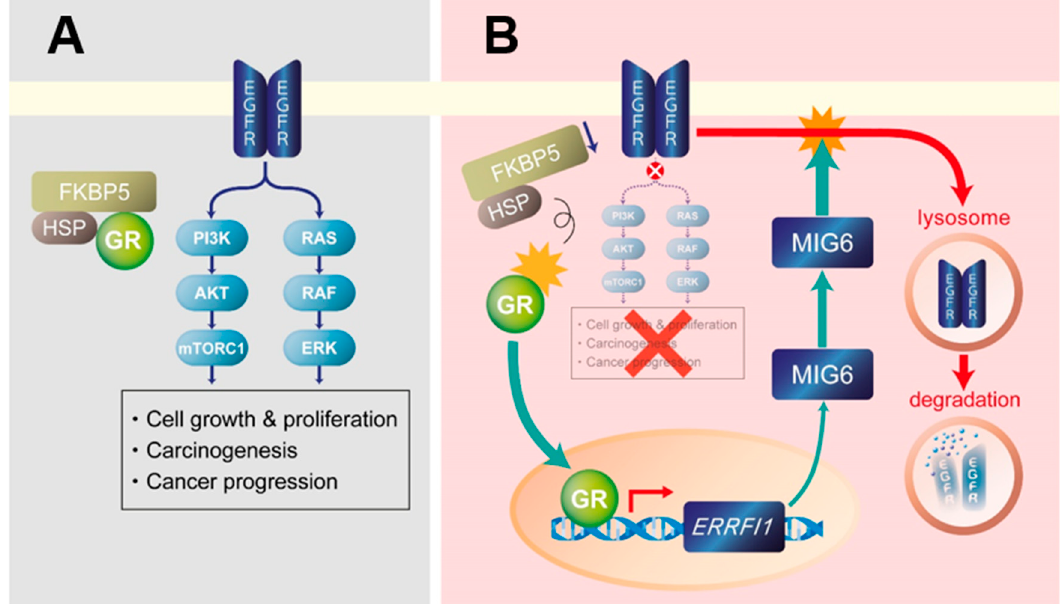
Figure 8. Proposed mechanism of glucocorticoid receptor (GR)–mitogen-inducible gene 6 (MIG6)-mediated epidermal growth factor receptor (EGFR) degradation and suppression by honokiol. ( A ) EGFR signaling plays a pivotal role in liver tumorigenesis by activating RAS/RAF/ERK and mechanistic (or mammalian) target of rapamycin complex 1 (mTORC1) signaling. FK506 binding protein 5 (FKBP5) and heat shock protein (HSP) cooperate to stabilize GR and inhibit its nuclear translocation in EGFR-expressing hepatocellular carcinoma cells. ( B ) Honokiol may cause GR to dissociate from the FKBP5/HSP complex. Once GR becomes free, it translocates to the nucleus and induces MIG6/ ERRFI1 transcription to eventually cause the lysosomal degradation of EGFR. As a result, EGFR signaling and its downstream targets RAS/RAF/ERK and mTORC1 are suppressed.